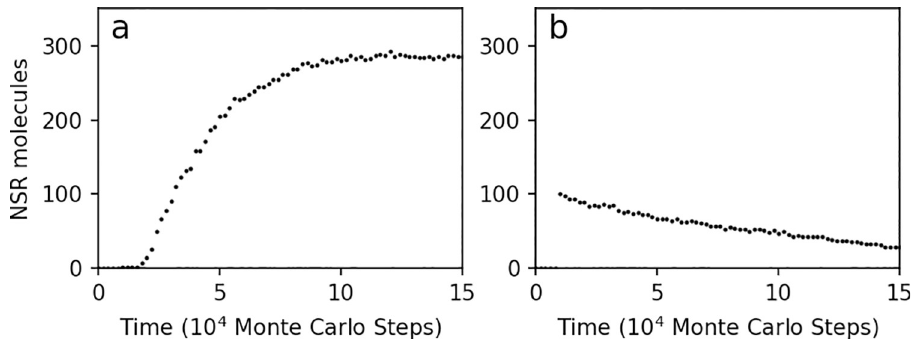
Fig 1. The evolutionary dynamics of molecular number of NSR in the modeling. ( a ) A typical case for the spread of NSR. One NSR molecule is inoculate at step 1 × 10 4 , and it replicates and becomes prosperous in the system [20]. Parameter values: PNF = 2 × 10 − 4 , PNFR = 0.9, PND = 0.01, PRL = 2 × 10 − 6 , PBB = 1 × 10 − 6 , PAT = 0.1, PFP = 0.01, and PMV = 0.01 (note that for a concise description we omit the other five parameters in the model which are not involved in the parameter-exploration here). ( b ) A case we assumed as the starting point for the machine-learning. One hundred NSR molecules are inoculated at step 1 × 10 4 , and the molecular number decreases gradually. Parameter setting: PNF = 4 × 10 − 3 , PNFR = 0.02, PND = 1 × 10 − 3 , PRL = 2 × 10 − 5 , PBB = 1 × 10 − 5 , PAT = 0.5, PFP = 0.1, and PMV = 1 × 10 − 3 . Obviously, such a parameter-setting does not favor the spread of the NSR. The NSR number at step 15 × 10 4 (i.e., the final step shown here) is adopted as the reference criterion–i.e. the objective function for machine- learning, which is expected to be improved through the following automatic parameter-adjustment